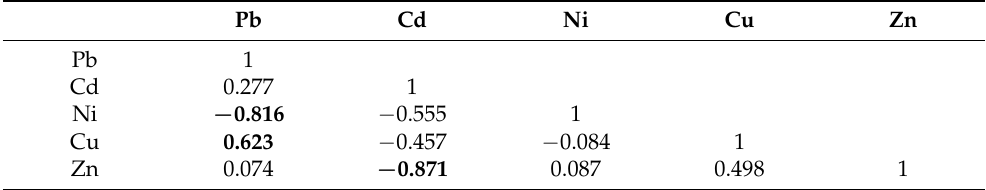
Table 5. Pearson correlation matrix among heavy metals ( n = 48).